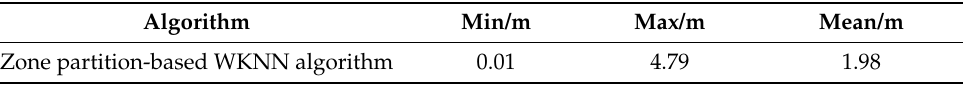
Figure 8. Figures of IMU-based and WiFi-based experiments results: ( a ) Figure of IMU-based positioning trajectory; ( b ) Figure of WiFi-based positioning trajectory. ( c ) Error figure of IMU-based positioning trajectory; ( d ) Error figure of WiFi-based positioning trajectory.